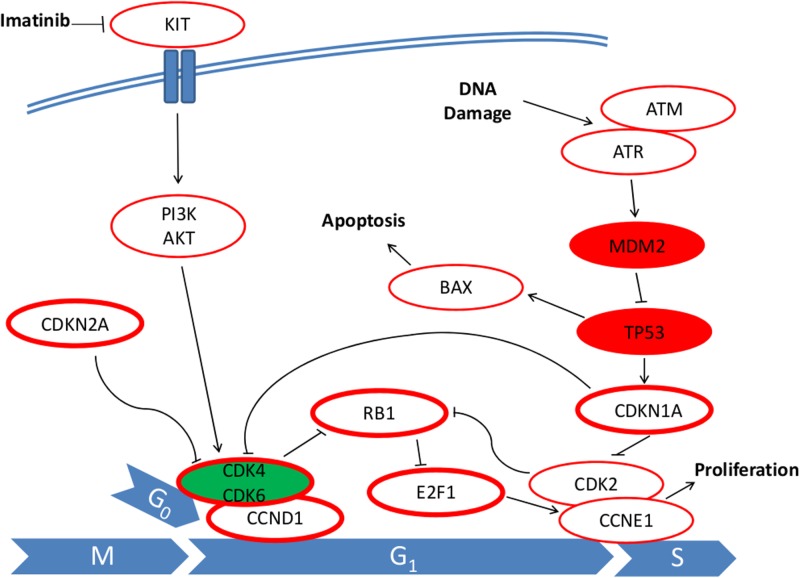
Model of cell cycle regulators and apoptosis modulators that are associated with impaired p53 (TP53) function in GIST.Constitutive activated KIT or PDGFRA promotes proliferation and can be inhibited by imatinib. Impaired p53 function leads as well to a higher proliferation and inhibits apoptosis by modulation of cell cycle regulators. The analyzed proteins are displayed as circles with a bold boarder. Filled green circles indicate that this protein is associated with a favorable recurrence free survival in our study, filled red circles indicate that these regulators are associated with an unfavorable recurrence free survival.